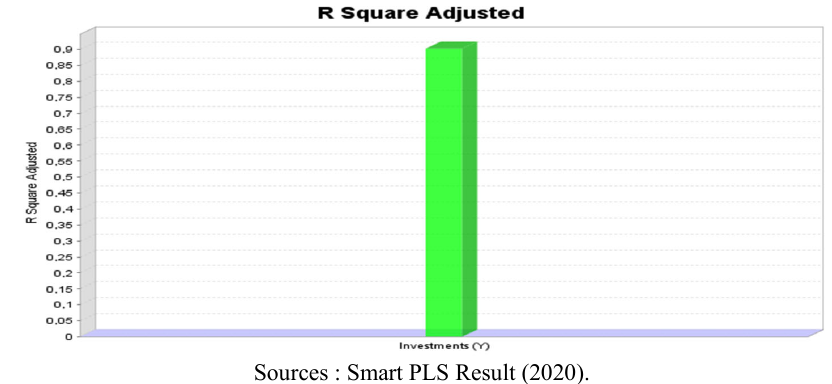
Sources : Smart PLS Result (2020).